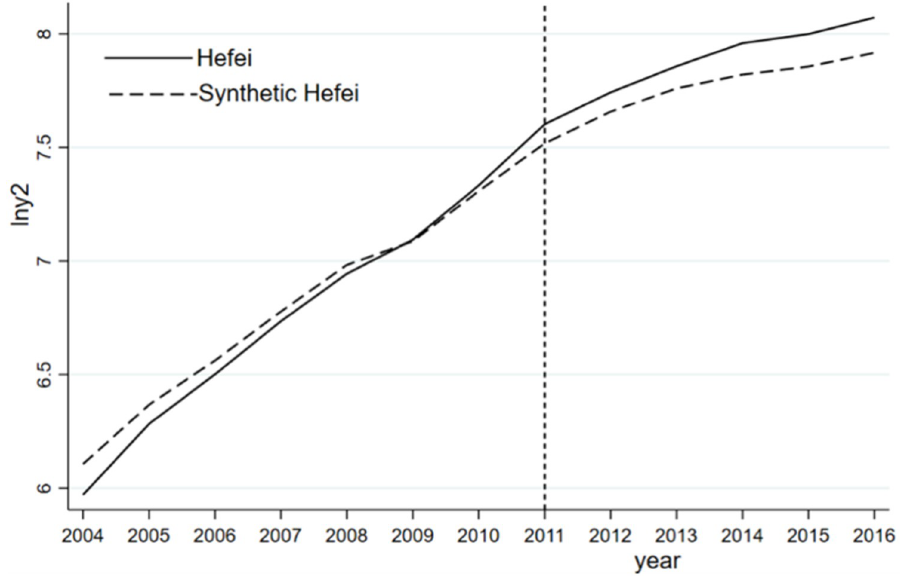
Fig 12. Log (GDP industry) of Hefei and synthetic